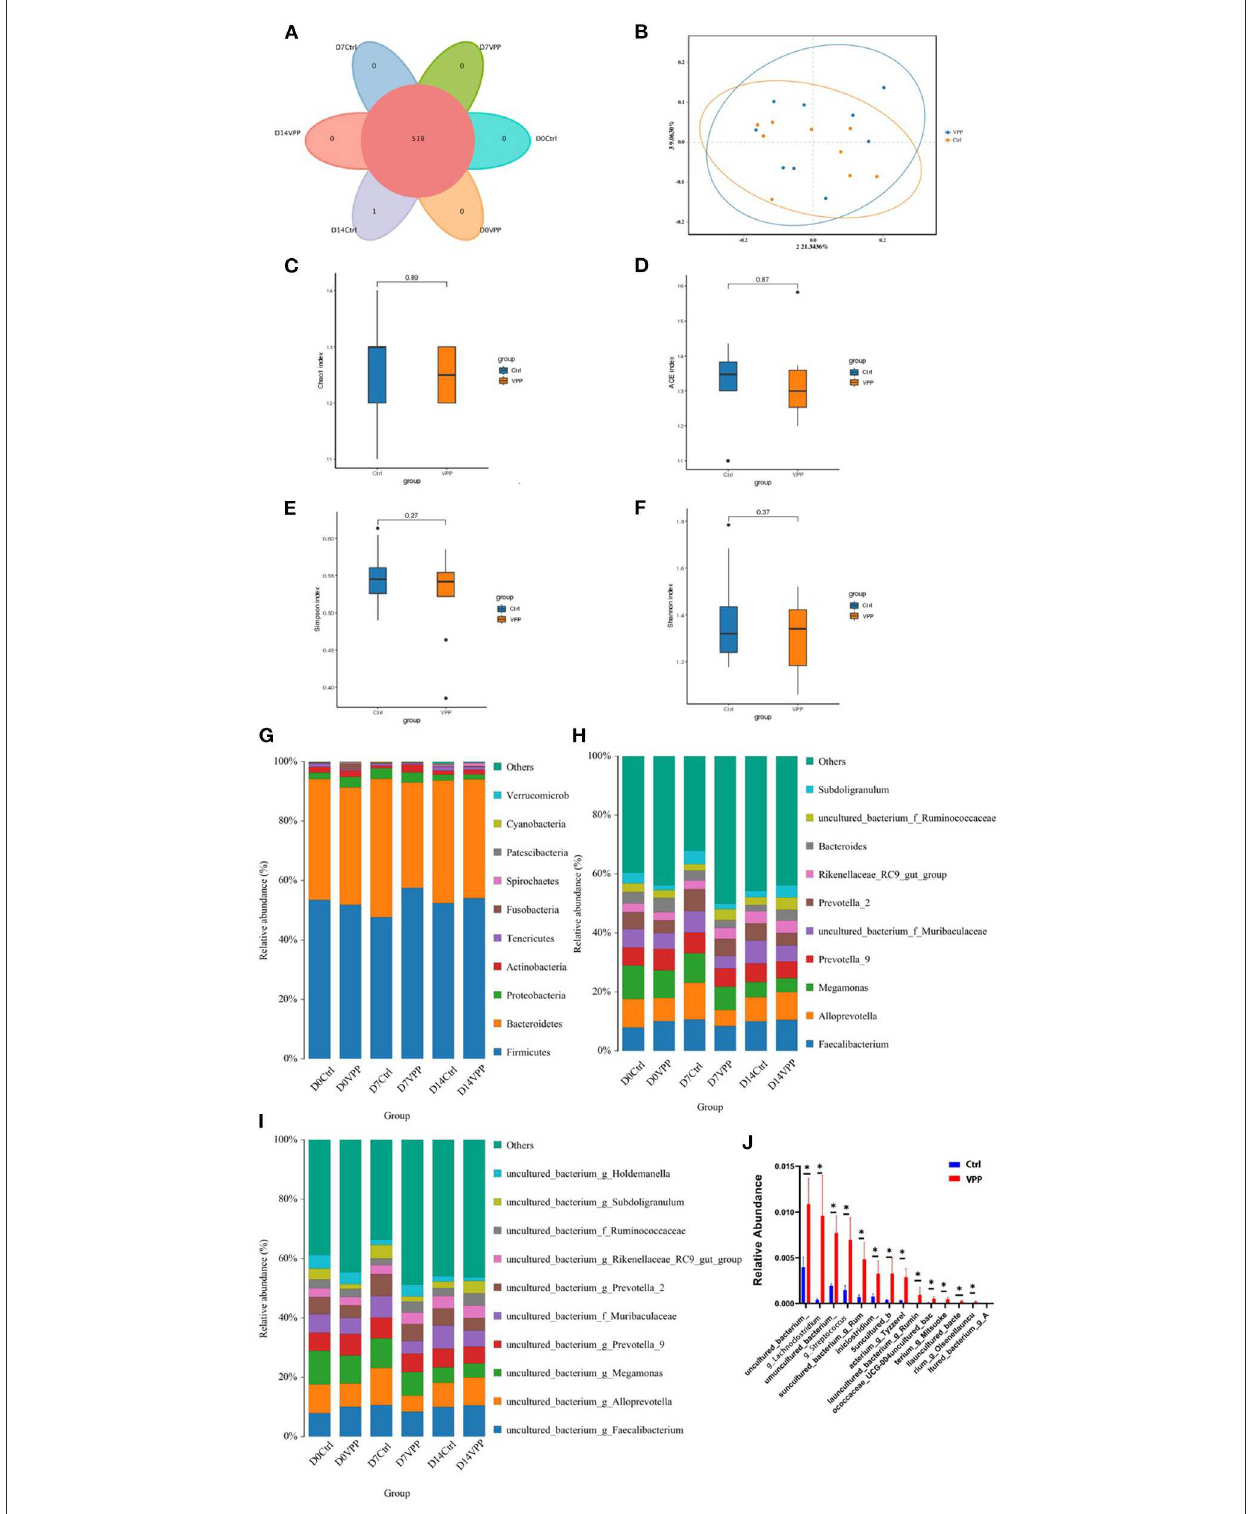
FIGURE4 Effects of VPP on fecal bacteria of pre-weaning calves. (A) Venn analysis based on operational taxonomic units. (B) Principal coordinates analysis of fecal bacterial communities. Ctrl, control. Alpha diversity indices: (C) Chao1 index, (D) Ace index, (E) Simpson index, and (F) Shannon index. Composition of bacterial communities (relative abundance): (G) phyla, (H) genera, and (I) species. (J) Relative abundance of species of fecal